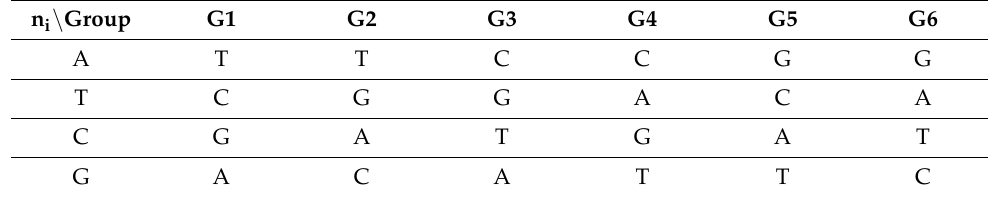
Table 1. DNA encoding rule.